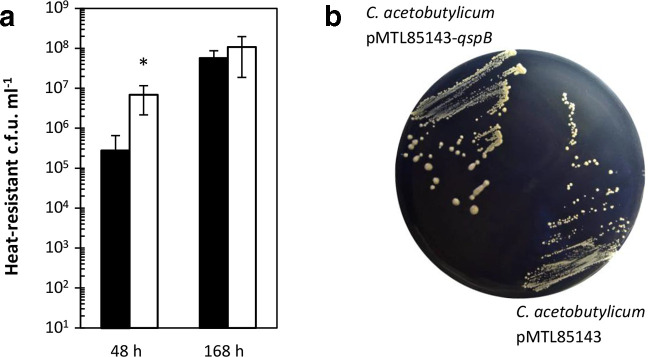
Effect of qspB overexpression on sporulation and colony size. (a) The ability to sporulate in CBMS was assessed for the
C. acetobutylicum
 ATCC 824 parent strain containing the empty pMTL85143 vector (black bars) and the overexpression plasmid pMTL85143-qspB (white bars). Data represent the mean of four independent cultures with error bars indicating the standard deviation. Significant differences (P≤0.05) compared to the vector controls are indicated by an asterisk next to the relevant measurement. (b) 5-day-old colonies of
C. acetobutylicum
 carrying the empty pMTL85143 vector (left) and overexpression plasmid pMTL85143-qspB, respectively, on CGM agar.